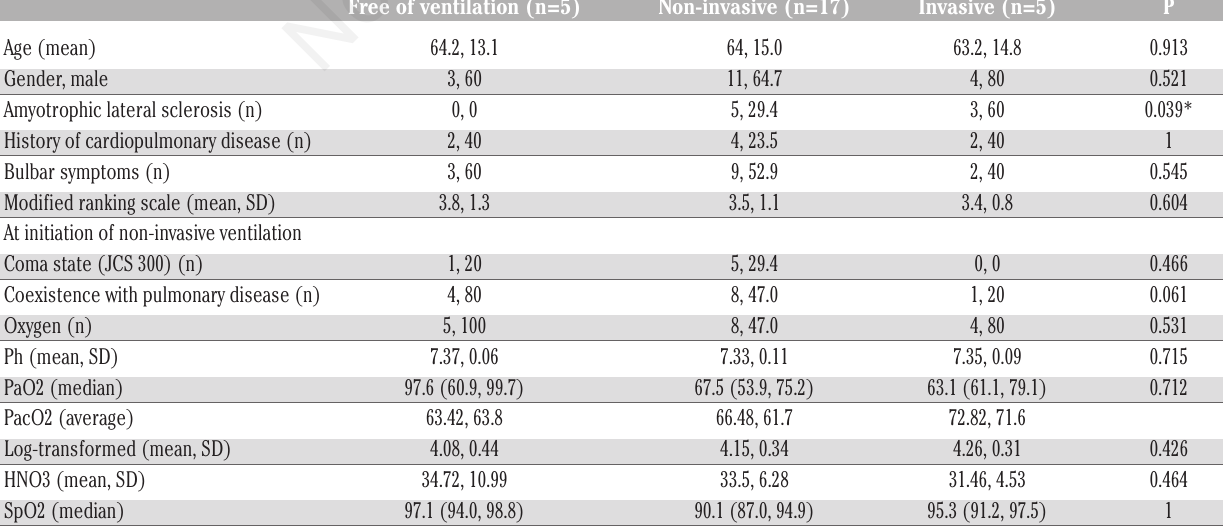
Table 1. Linear regression analysis of differences in clinical factors before the onset of acute respiratory failure among patients who received continuous noninvasive mechanical ventilation support, those who were switched from noninvasive to invasive ventilation, and those in whom noninvasive mechanical ventilation was discontinued.